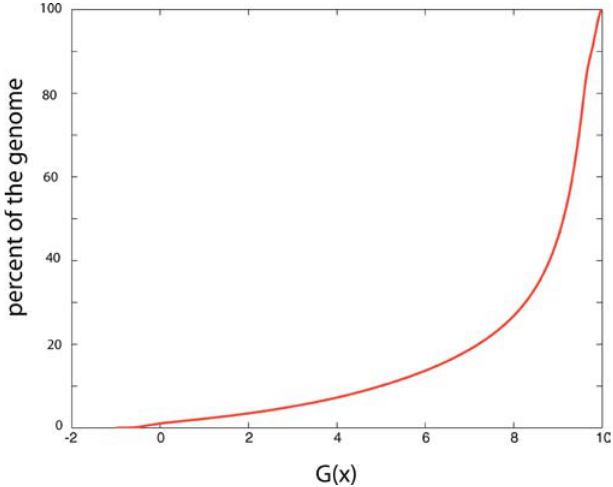
Figure 2. The Cumulative Distribution of Destabilization Levels G ( x ) for the Entire Yeast Genome For each value of G on the horizontal axis, this curve plots the number of base pairs (expressed as a percent of the genome) needing that amount of free energy (or less) to strand separate. G ¼ 10 kcal/mol is sufficient to open any base pair in the genome. DOI: